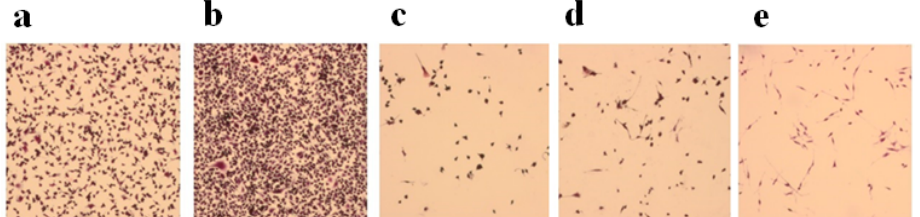
Figure 2. Representative images of polynucleated osteoclasts following RANK ligand treatment marked with TRAP, demonstrating the presence of tartrate-resistant acid phosphatase in osteoclasts. Inhibitory effects of osteoclastogenesis by alendronate (ALE), risedronate (RIS), and zoledronic acid (ZOL) tested at 10 − 4 M concentrations are shown at 10× magnification. Cells were treated with ( a ) normal medium; and medium with ( b ) RANKL, ( c ) ALE, ( d ) RIS, and ( e ) ZOL (Magnification is 10×).